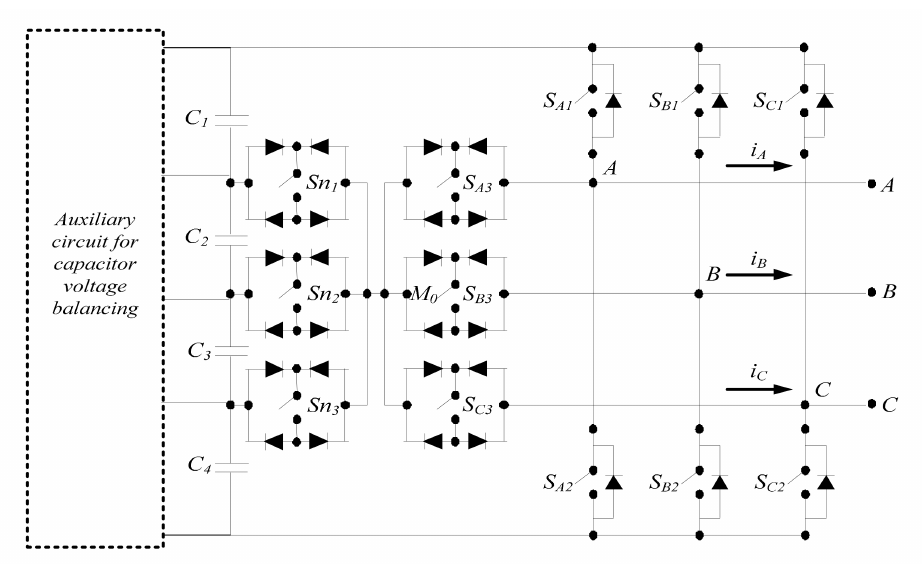
Figure 1. Five-level switch-sharing-based multilevel